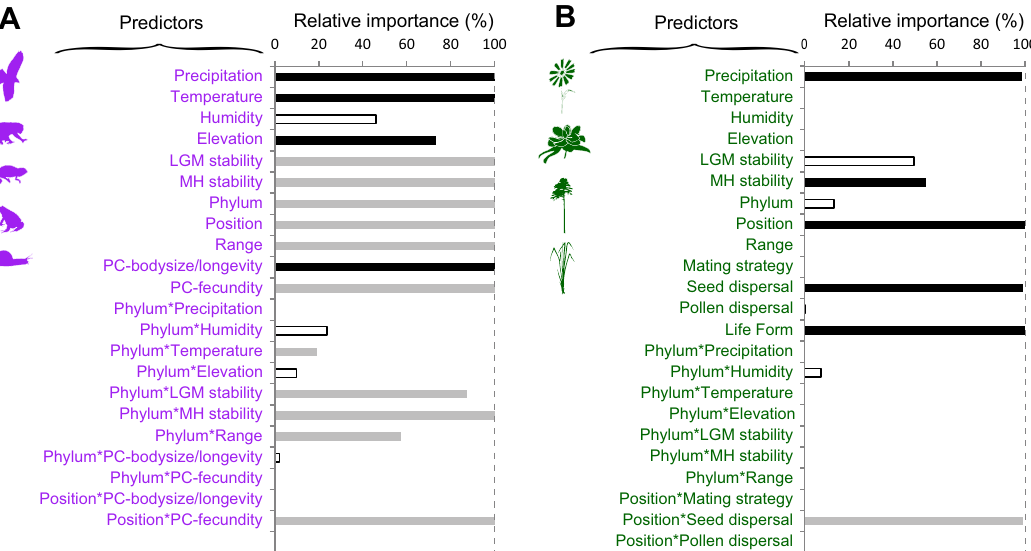
Fig. 3 Relative importance of predictors used in the animal and plant kingdom models. An information theoretic approach was used to identify the most important predictors of animal ( A ) and plant ( B ) GD p , respectively. Predictors with relative importance higher than 50% (i.e. the relative cumulative Akaike weight for the set of models with Δ AIC < 4) are considered as signi fi cant contributors to GD p . Color code indicates “ non-signi fi cant ” predictors (RI < 50%, white bars), “ signi fi cant ” predictors not depending on phylum or on the relative position of the population (RI > 50%, black bars) and “ signi fi cant ” predictors depending either on phylum or on the relative position of the population (RI > 50%, grey bars). When bars are absent the relative importance of the predictor is 0%. Please see Tables S8 and S9 for all models with Δ AIC < 4. Source data are provided as a Source Data fi